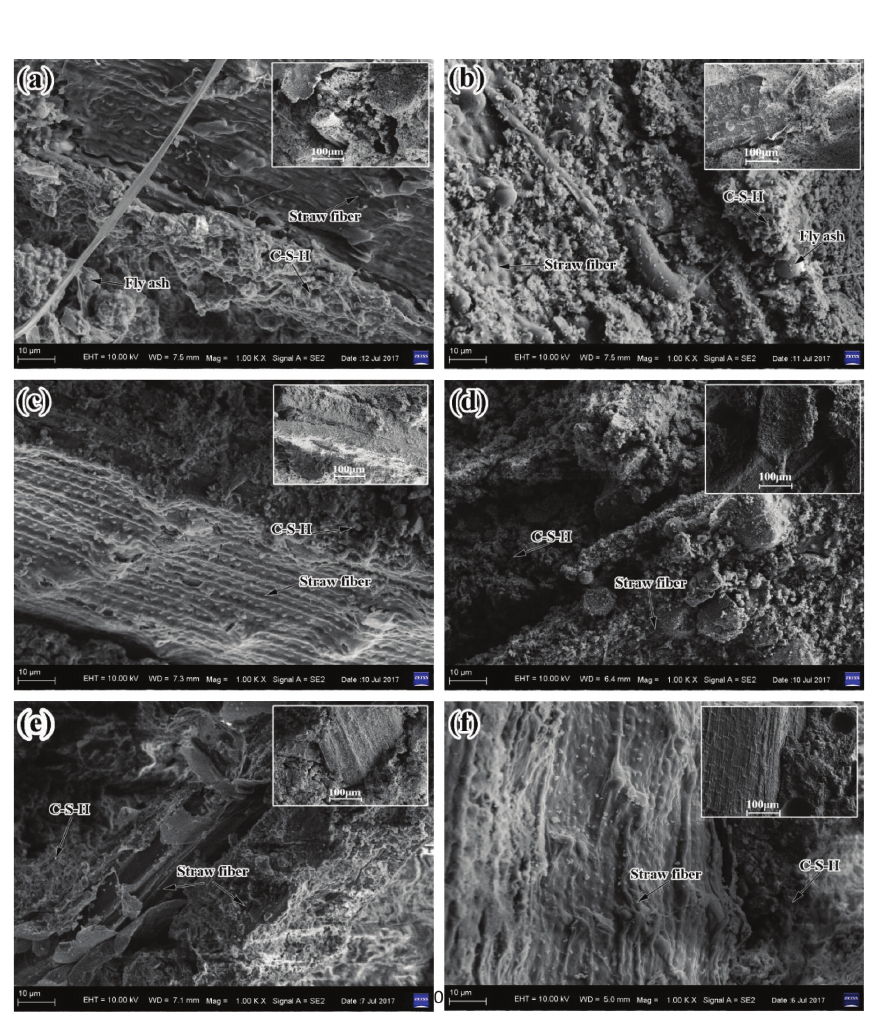
Figure 9: SEM images of SFCC (1000